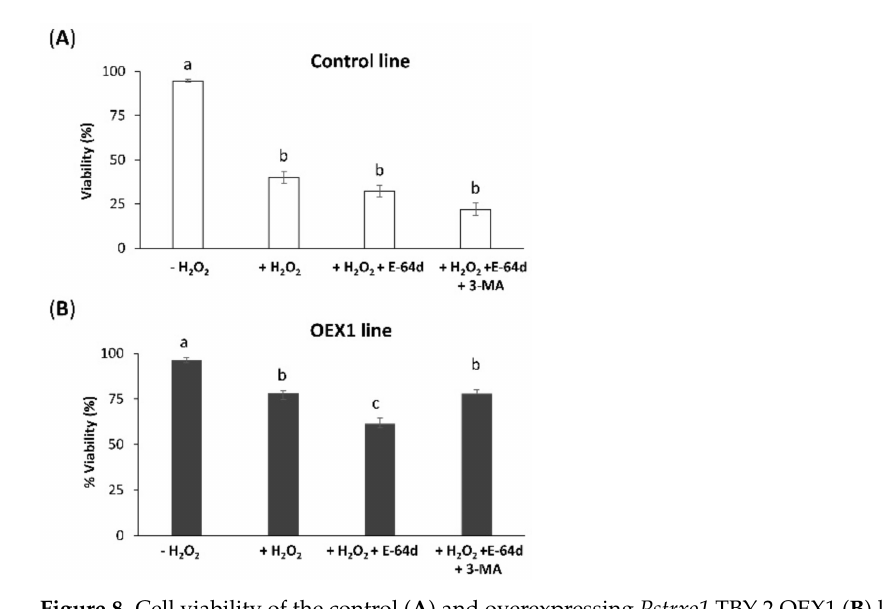
Figure 8. Cell viability of the control ( A ) and overexpressing Pstrxo1 TBY-2 OEX1 ( B ) lines 14 h after treatment with 35 mM H 2 O 2 in the absence and presence of the autophagy inhibitors E-64d and 3-MA. Cell viability (percentage) of cells without treatment (-) and after treatment with H 2 O 2 , H 2 O 2 + E-64d, and H 2 O 2 + E-64d + 3-MA was tested using Trypan Blue dye 14 h after oxidative treatment. Values represent mean ± standard error of four independent experiments. Different letters indicate significant differences ( p < 0.05) among treatments according to Tukey’s test.